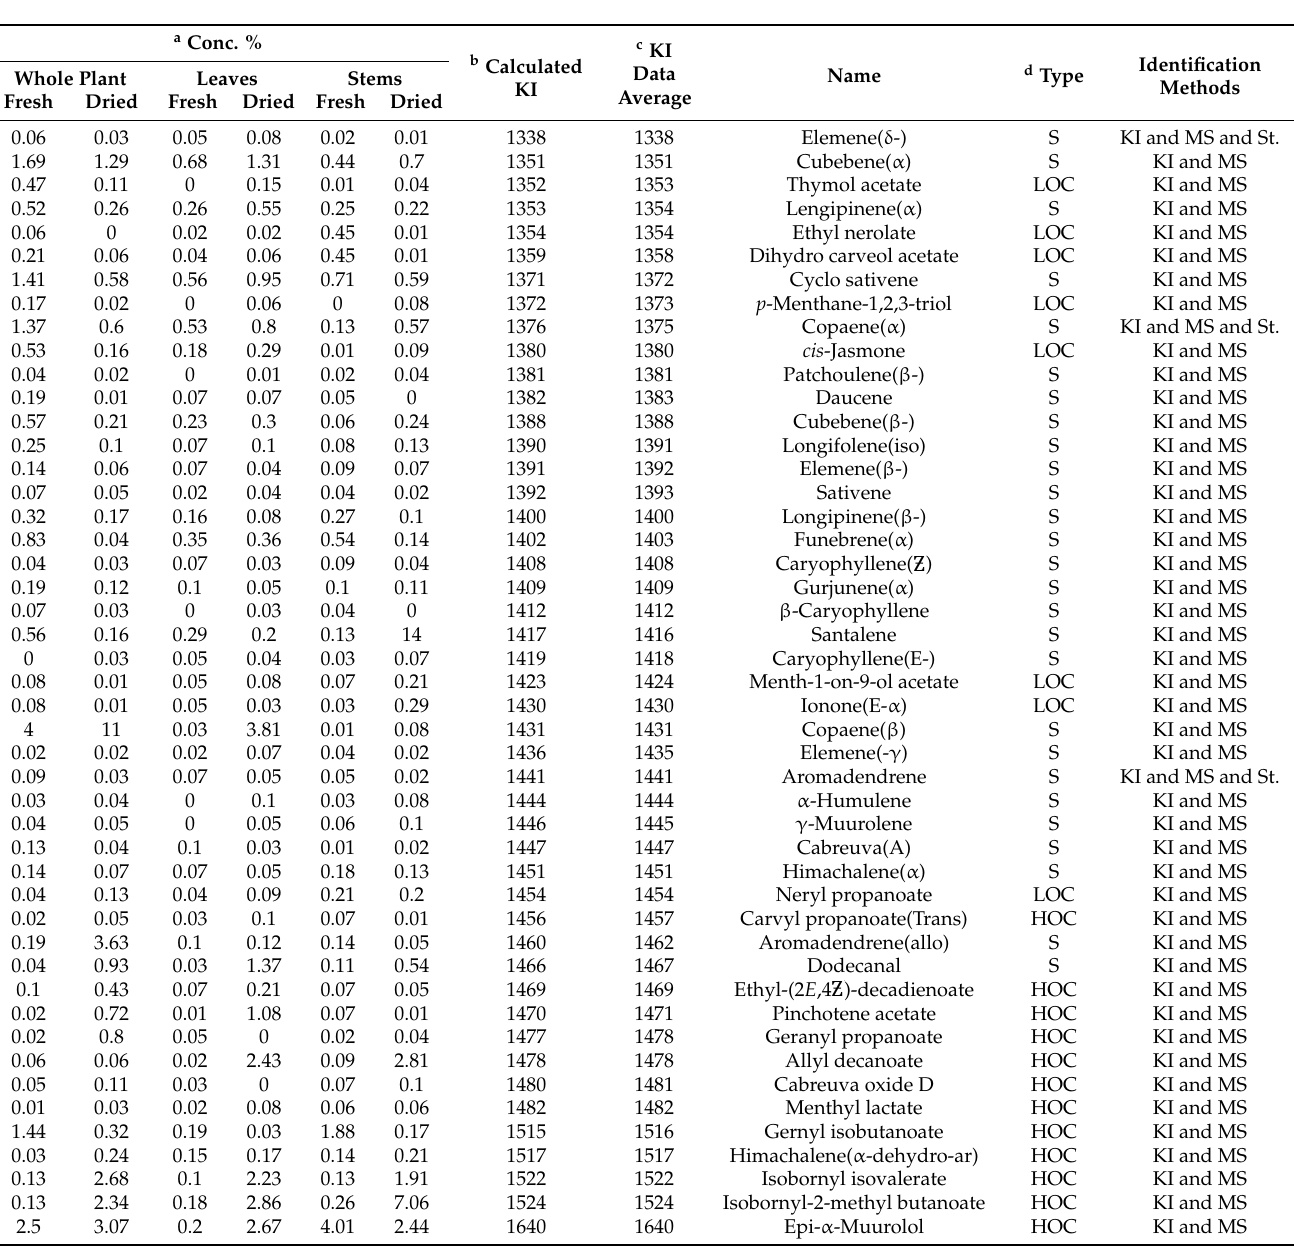
Table 1. Chemical components of volatile oils from fresh and dried Mentha suaveolens L. analyzed by GC/FID and GC/MS.